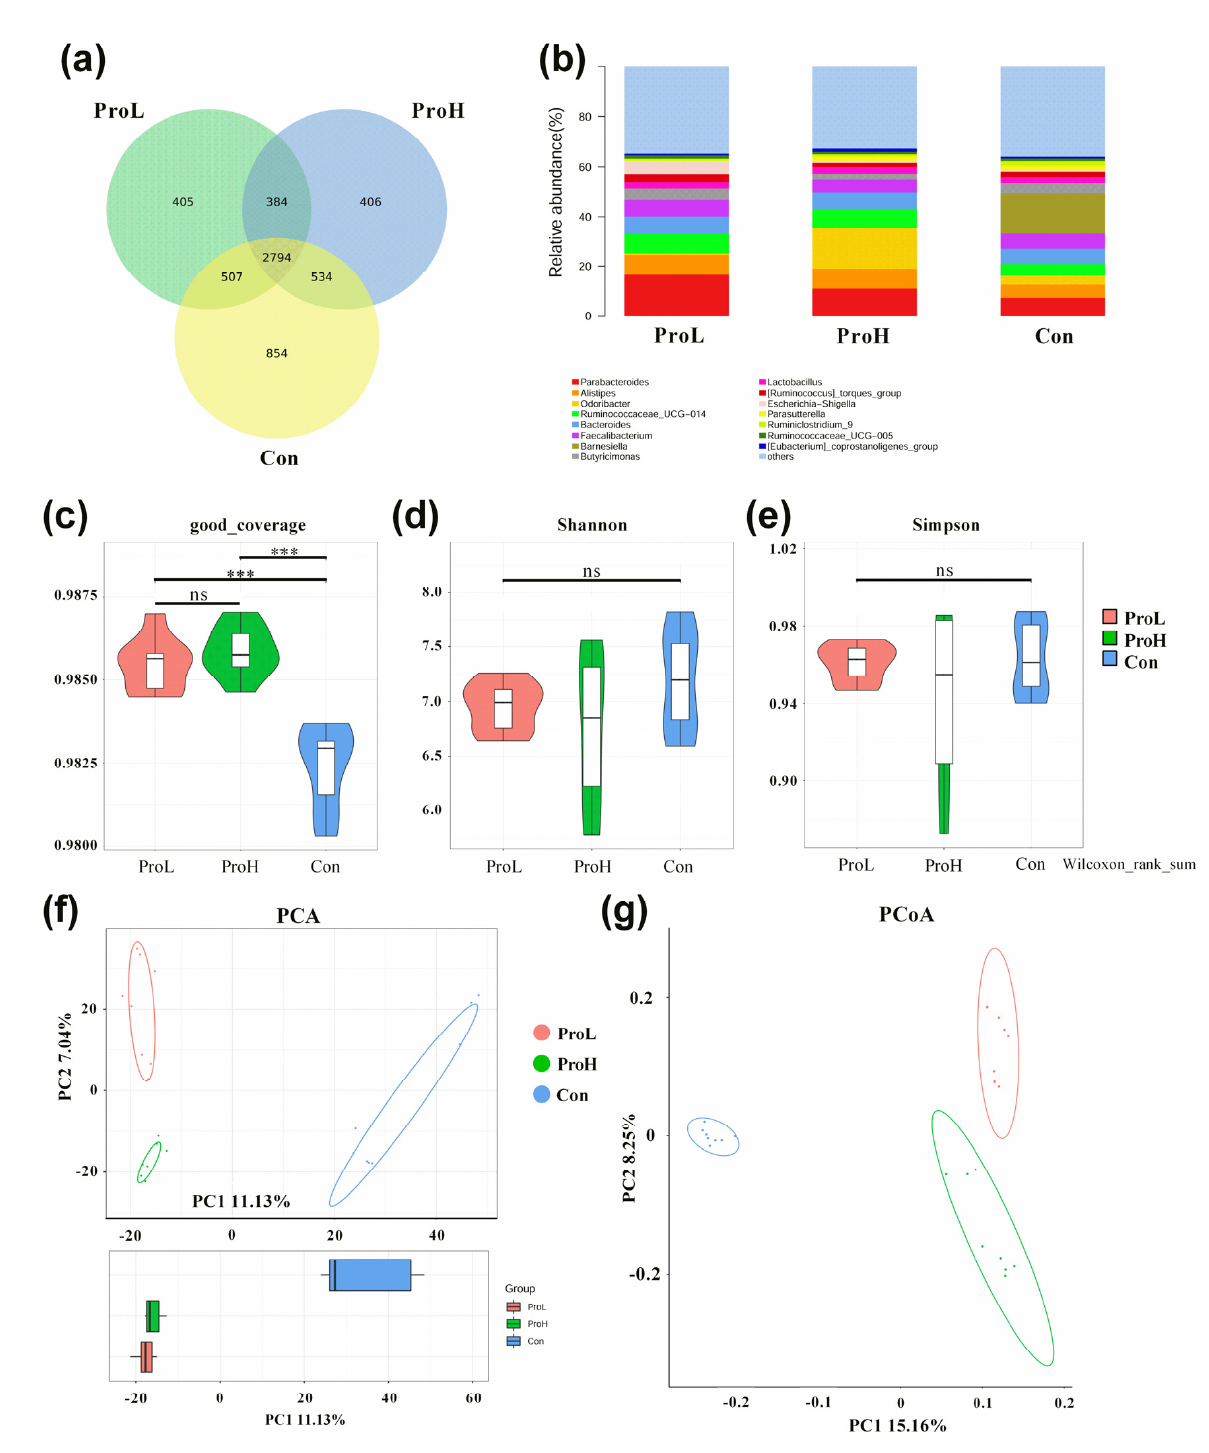
Figure 5. Summary of compound probiotics that modulated the caecal microflora community in broilers on d 42. ( a ) Venn chart; ( b ) representative genera in all samples; ( c ) good coverage; ( d ) Shannon index; ( e ) Simpson index; ( f ) PCA plot; ( g ) PCoA plot. *** represents a significant difference ( p < 0.001); ns represents no significant difference. Con birds were fed a basal diet; ProL birds were fed a basal diet added into 10 10 probiotics cfu/kg; ProH birds were fed a basal diet added into 10 11 probiotics cfu/kg ( n = 8).